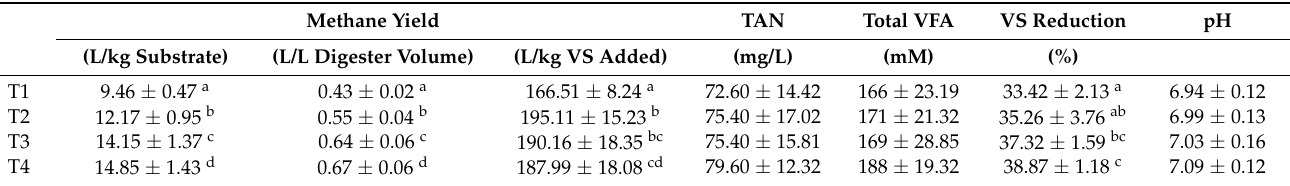
Figure 2. Trends of methane production in continuous study. Table 5. Methane yield, TAN concentration, total VFA, VS reduction and pH value of digested bio-slurry. Methane Yield